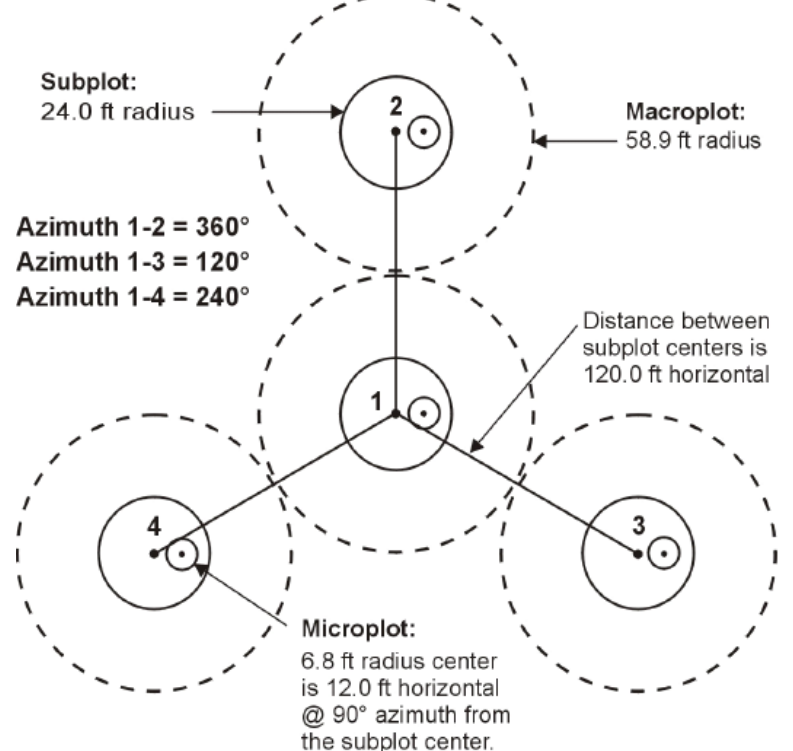
Figure 3. FIA plot configuration [15]. Metric units: subplots have a radius of 7.3 m with subplot centers 36.6 m apart; microplots have a radius of 2.1 m and are located 3.6 m from subplot centers; and macroplots were not used in this study.